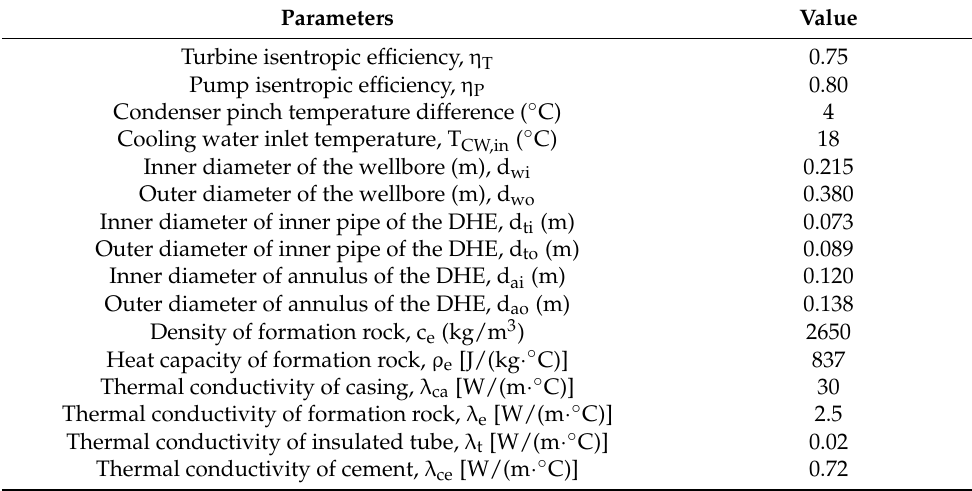
Table 2. Parameters used in the simulation. Parameters Value Turbine isentropic efficiency, η T 0.75 Pump isentropic efficiency, η P 0.80 Condenser pinch temperature difference ( ◦ C) 4 Cooling water inlet temperature, T CW,in ( ◦ C) 18 Inner diameter of the wellbore (m), d wi 0.215 Outer diameter of the wellbore (m), d wo 0.380 Inner diameter of inner pipe of the DHE, d ti (m) 0.073 Outer diameter of inner pipe of the DHE, d to (m) 0.089 Inner diameter of annulus of the DHE, d ai (m) 0.120 Outer diameter of annulus of the DHE, d ao (m) 0.138 Density of formation rock, c e (kg/m 3 ) 2650 Heat capacity of formation rock, ρ e [J/(kg · ◦ C)] 837 Thermal conductivity of casing, λ ca [W/(m · ◦ C)] 30 Thermal conductivity of formation rock, λ e [W/(m · ◦ C)]